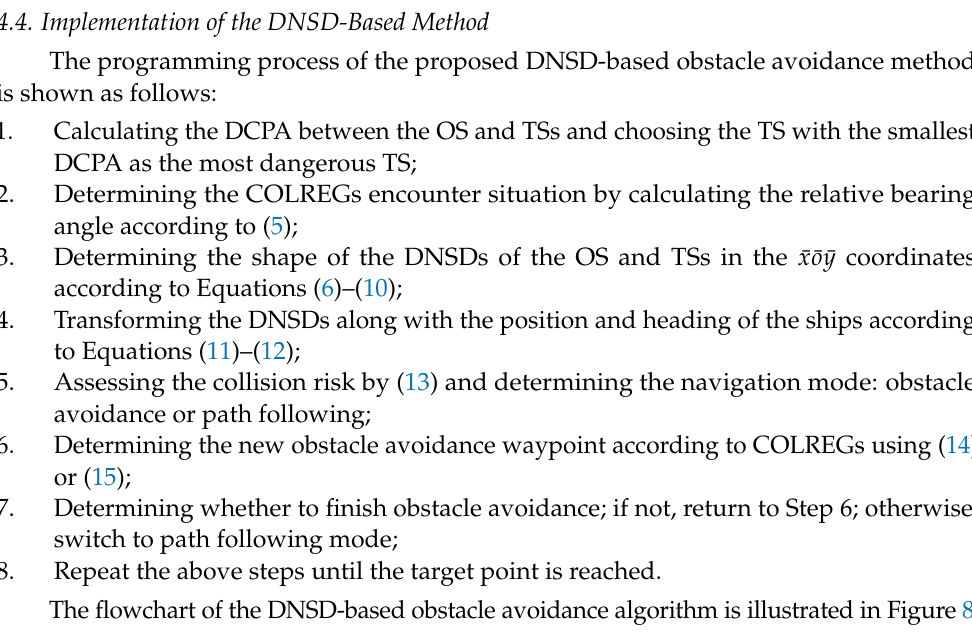
Figure 7. Finish obstacle